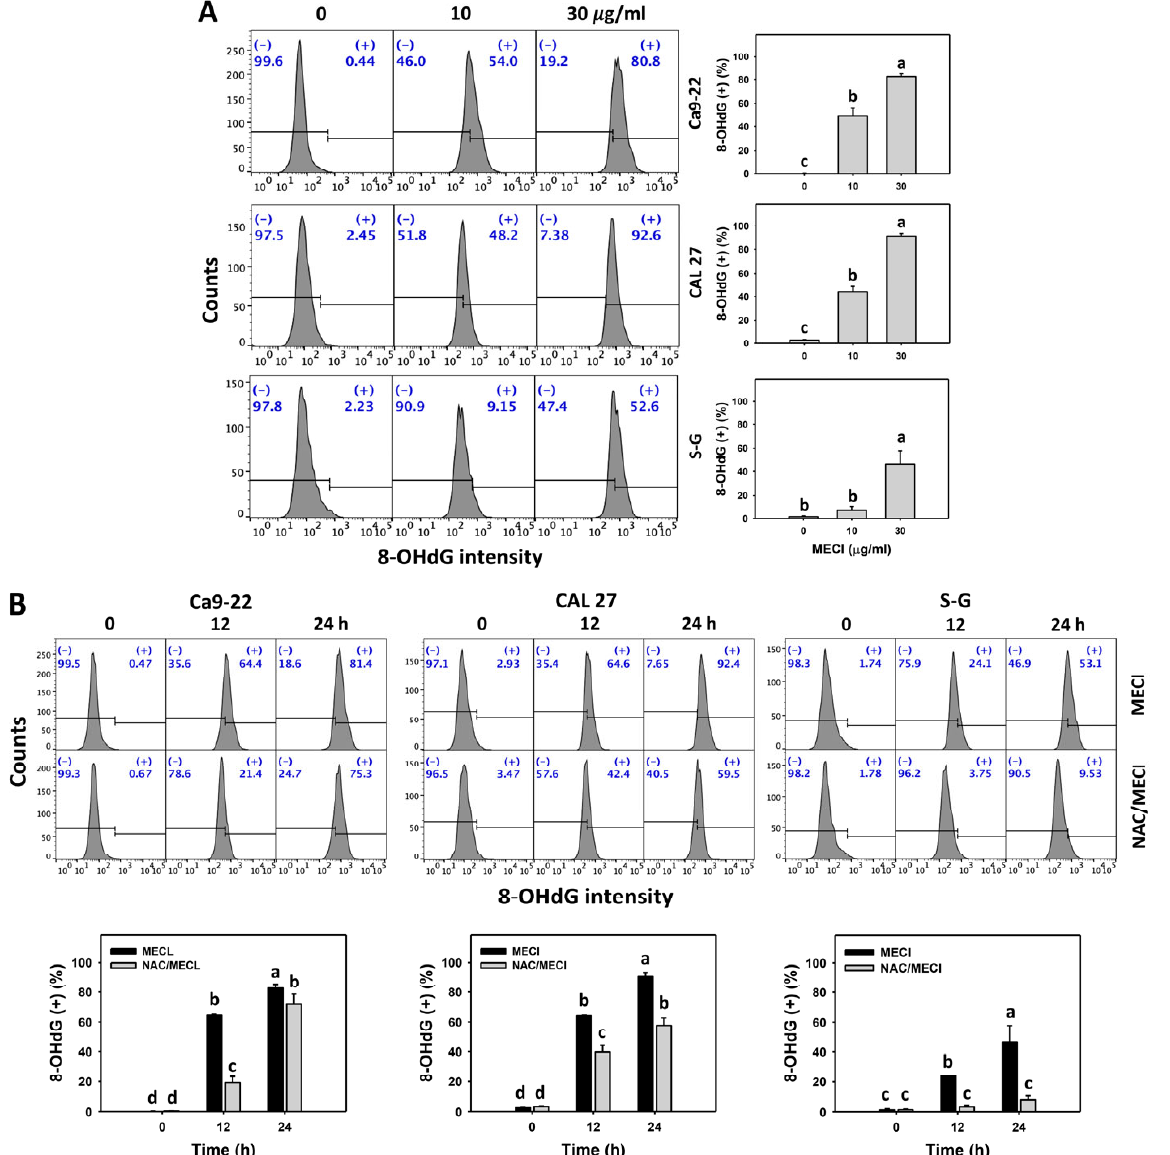
Figure 10. 8-OHdG assay. ( A ) 8-OHdG change. Except for S-G cells, other cells were oral cancer cells. Figure 10. 8 ‐ OHdG assay. ( A ) 8 ‐ OHdG change. Except for S ‐ G cells, other cells were oral cancer After 24 h MECI incubation (0 (0.1% DMSO in the medium), 10, and 30 µ g/mL), cells were applied cells. After 24 h MECI incubation (0 (0.1% DMSO in the medium), 10, and 30 μ g/mL), cells were to 8-OHdG assays. (+) spots were specified for 8-OHdG (+). ( B ) Impact of NAC on MECI-induced applied to 8 ‐ OHdG assays. (+) spots were specified for 8 ‐ OHdG (+). ( B ) Impact of NAC on MECI ‐ 8-OHdG change to oral cancer cells. After pretreating with NAC, cells were post-treated with MECI induced 8 ‐ OHdG change to oral cancer cells. After pretreating with NAC, cells were post ‐ treated (30 µ g/mL) for 0, 12, and 24 h. Data, mean ± SD ( n = 3). Columns showing non-overlapping letters with MECI (30 μ g/mL) for 0, 12, and 24 h. Data, mean ± SD ( n = 3). Columns showing non ‐ overlap ‐ differ significantly ( p < 0.05). ping letters differ significantly ( p < 0.05). The impact of ROS on the regulation of the γ H2AX and 8-OHdG (+) levels by MECI was assessed using an ROS inhibitor (NAC). The γ H2AX and 8-OHdG (+)-increasing status of MECI in oral cancer cells at time-lapse was inhibited by pretreatment with NAC (Figures 9B and 10B). Based on graphs and statistics presented in Figure 9, the Ca9-22 and CAL 27 oral cells displayed the highest level of NAC-mediated protection against γ H2AX formation by MECI. In Figure 10, the S–G normal oral cells displayed the highest level of NAC-mediated protection against 8-OHdG formation by